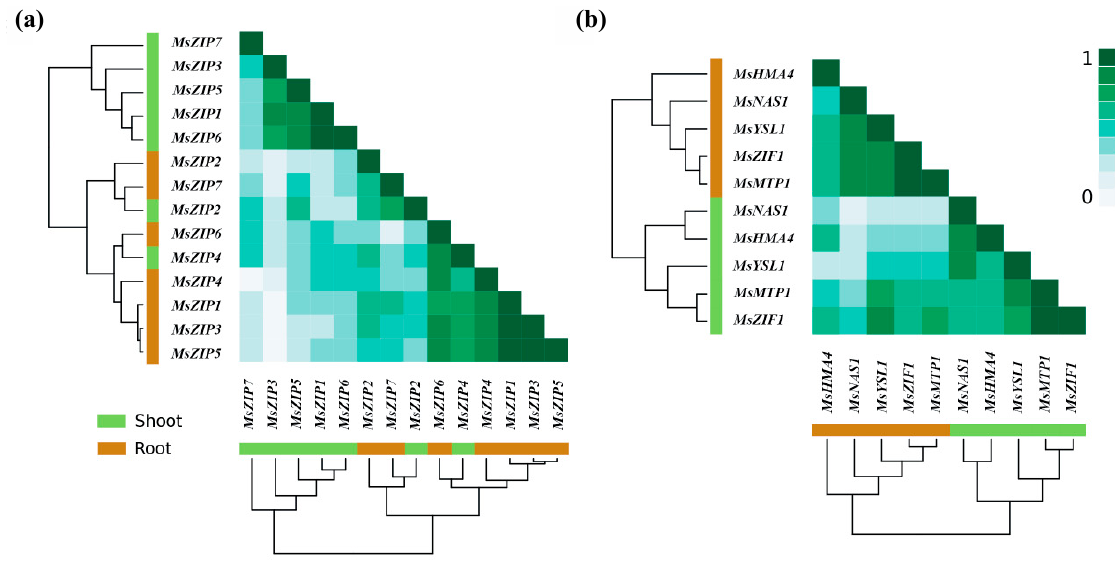
Figure 5. Heatmaps reporting correlations between expression of genes related to Zn transport after foliar Zn application. Gene expression is calculated as the difference between 0.1, 1, or 10 mg Zn plant − 1 and a control of 0 mg Zn plant − 1 . The similarity in the degree of correlation in fold-change of gene expression to Zn application relative to the control was based on the average linkage clustering of the Pearson correlations ( r ). In the clustering trees, the genes are indicated in brown for roots and in green for shoots, while the ranks of correlations of the heatmap are indicated by color intensity ( r 0 to 1: from low to strong intensity of green). Seven genes encoding transmembrane Zn transporter ( MsZIP1-7 ) ( a ); four genes encoding cellular Zn transporters (including vacuolar transporters) ( MsZIF1 , MsHMA4 , MsYSL1 , and MsMTP1 ) and a gene encoding a nicotianamine synthase ( MsNAS1 ) ( b ).